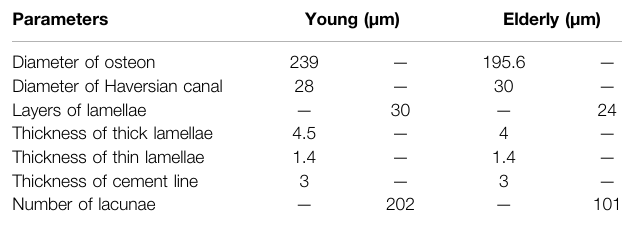
TABLE 4 | The geometrical parameters of the osteon (Ardizzoni, 2001; Bernhard et al., 2013; Hemmatian et al.,